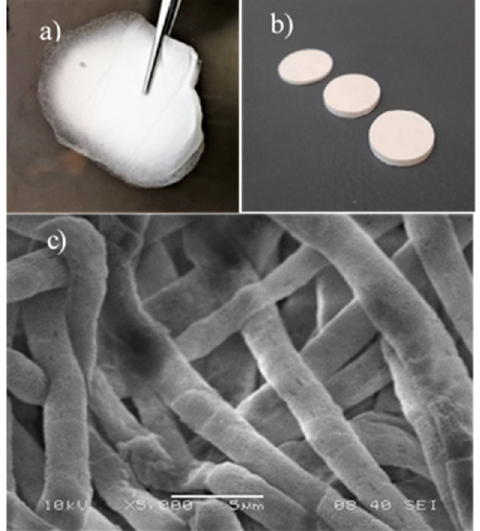
Figure 1. Morphology of PLA/Amox fibers at the different steps of preparation; ( a ) image of the fiber mat; ( b ) image of compressed disks; ( c ) SEM micrograph recorded on the fractured surface of a disk prepared from the electrospun PLA fibers.